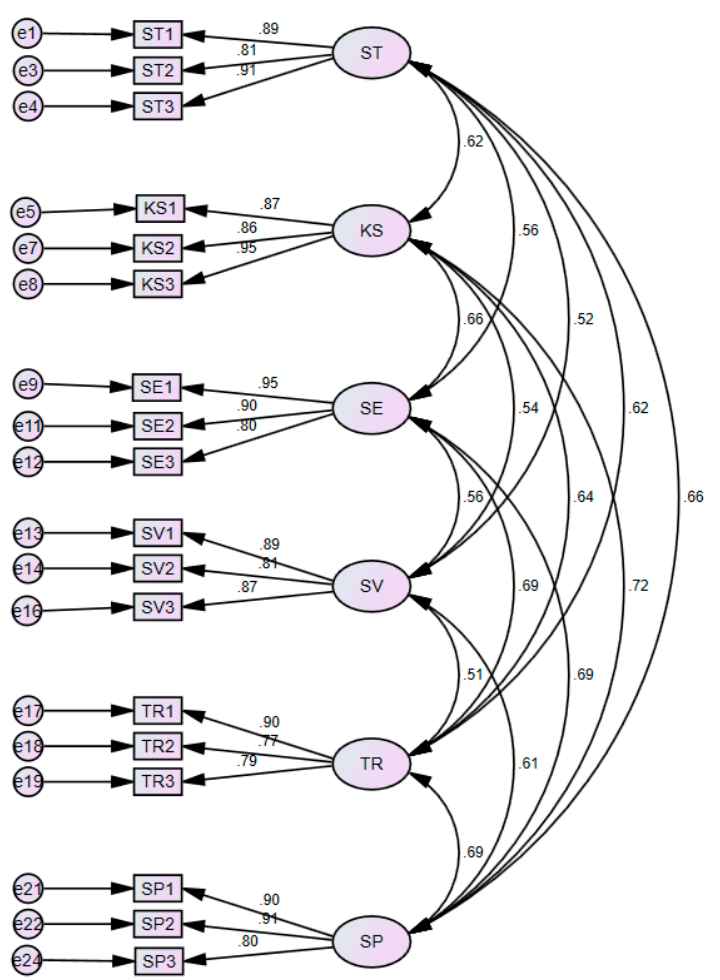
Figure 3. The measurement model.